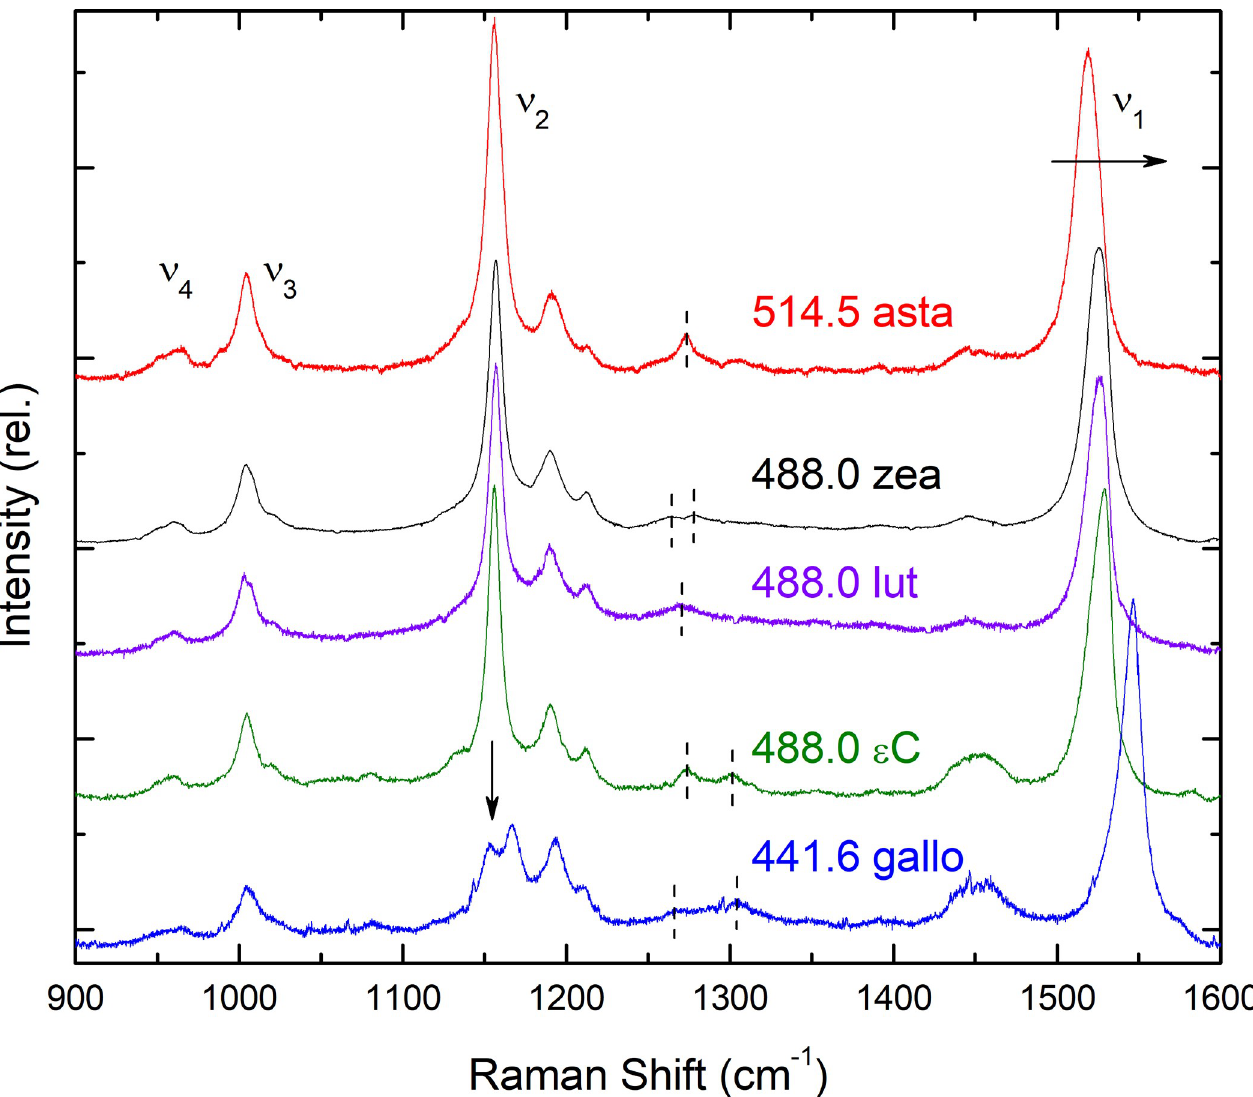
Fig 3. Resonance Raman spectra of avian retinal carotenoids. Spectra are shown at room temperature in the 900–1600 cm -1 region, for the carotenoids in Fig 1, dissolved in n-hexane. The excitation wavelength used is indicated in each case in nm; asta–astaxanthin, zea–zeaxanthin, lut–lutein, ε C– ε -carotene; gallo— galloxanthin. Differences between the spectra discussed in the text are indicated by dashed lines and